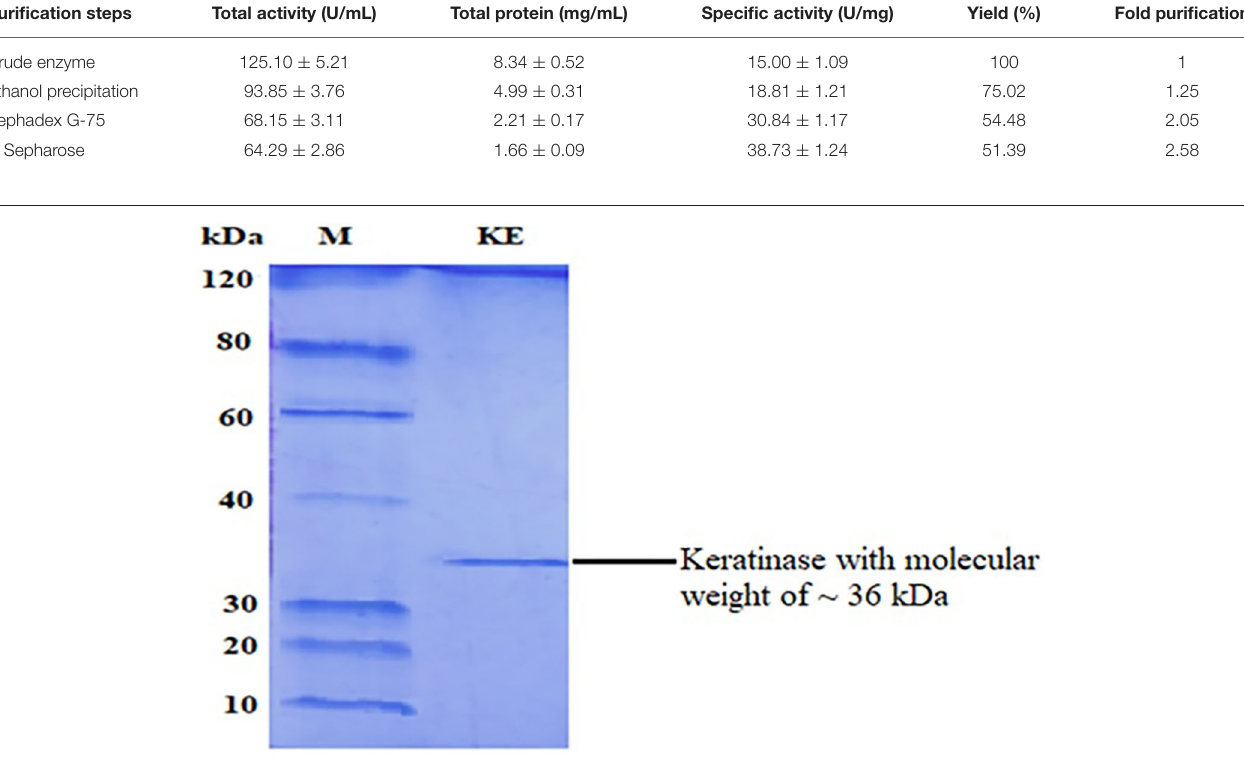
FIGURE 2 | SDS-PAGE of purified keratinase. M, protein marker; KE,